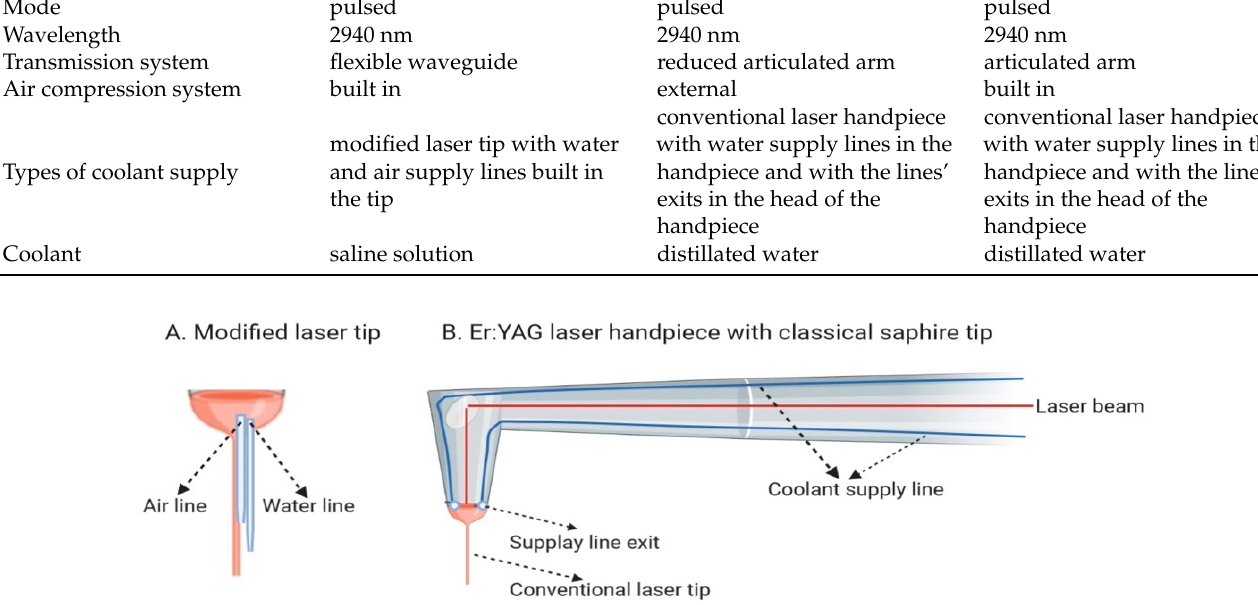
Figure 2. Types of coolant supply in erbium family lasers. ( A ) Modified laser tip with water and air supply lines built in the tip. (AdvErL Evo laser); ( B ) Conventional laser handpiece with water supply lines in the handpiece and with the lines’ exits in the head of the handpiece (next to the tip socket (LiteTouch and LightWalker lasers).